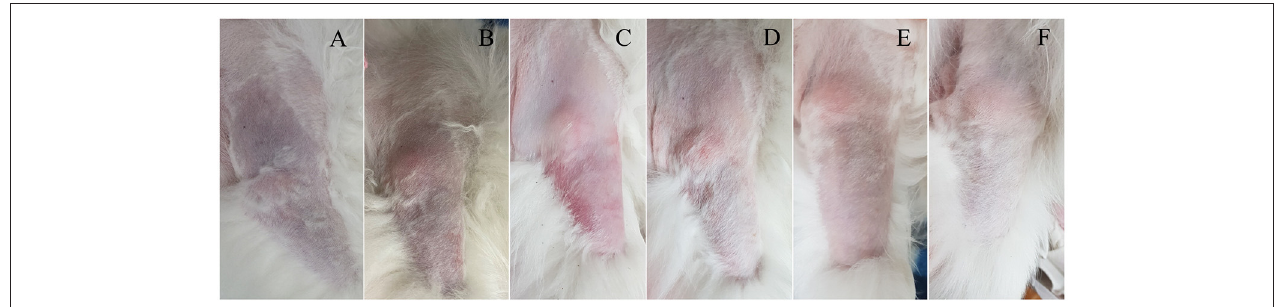
FIGURE 1 | Clinical course of unilateral cyanotic forelimb with suspected arterial thrombosis in a dog following thrombolytic therapy. (A) Cyanosis was confirmed from the proximal third of the right forelimb on the presentation day, and the skin color became normal over time (B–F) . The right forelimb skin color on the following days: day 0 (A) , day 1 (B) , day 2 (C) , day 4 (D) , day 6 (E) , and day 21 (F)